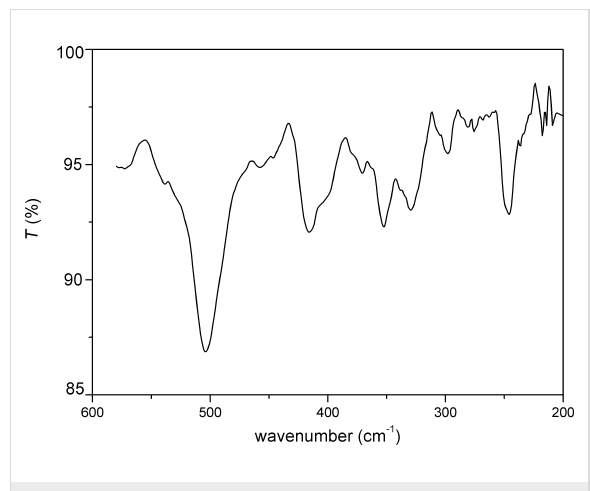
Figure 5: Far-IR spectrum of Pt-DEA (Pt/DEA 1:1) nanoparticles